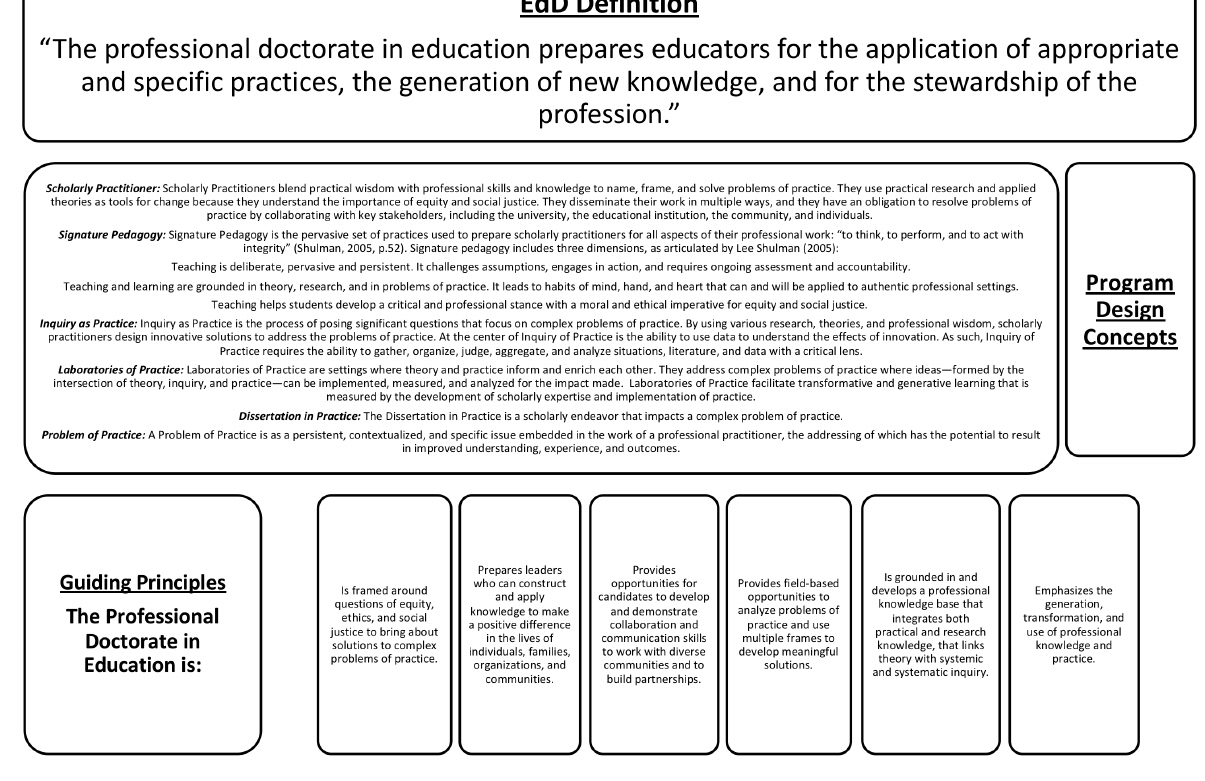
Table 1. CPED Framework: Members of CPED developed a Framework for EdD program design/redesign that supports creating quality, rigorous practitioner preparation while honoring the local context of each member